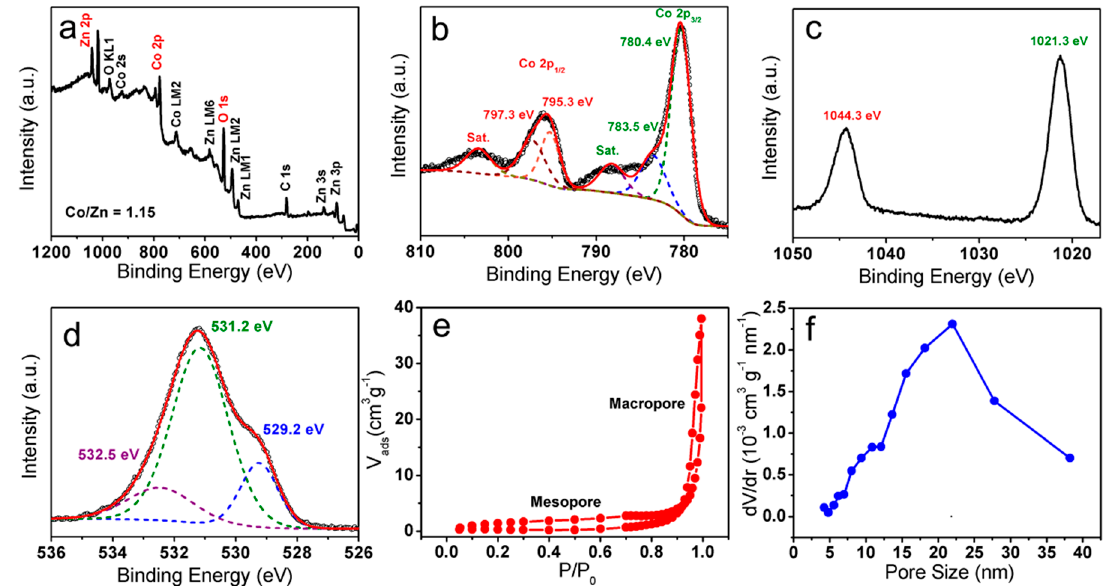
Figure 4. ( a ) Full X-ray photoelectron spectroscopy (XPS) scan, ( b ) Co 2p, ( c ) Zn 2p, and ( d ) O 1s XPS scans of the CoZn-MOH-45-110 sample. ( e ) N 2 (77 K) adsorption/desorption isotherms and ( f ) Barrett-Joyner-Halenda (BJH) pore size distribution curves of CoZn-MOH-45-110 sample supported on nickel foam.